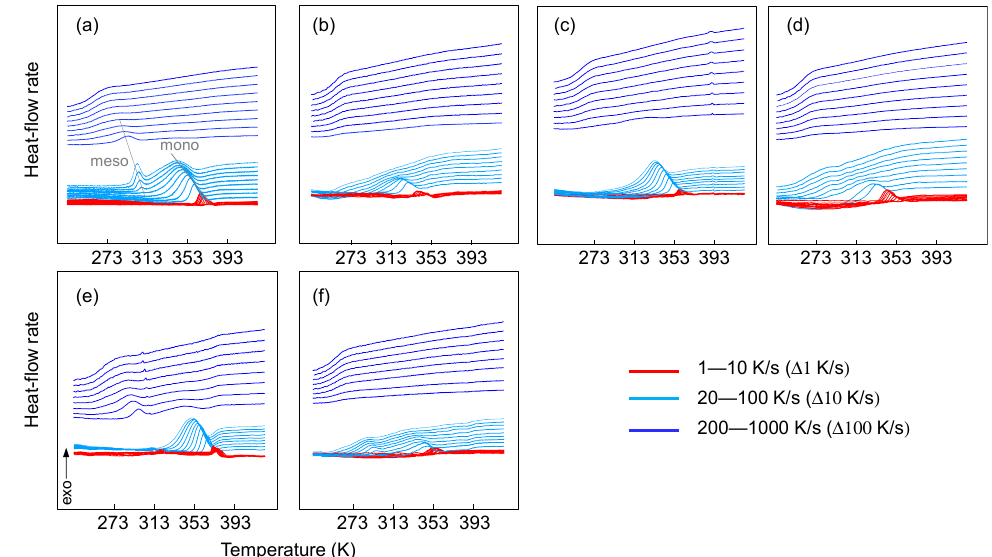
Figure 2. Heat-flow rate data collected on cooling of propylene homopolymers and random copolymers based on SSC ( top ) and ZNC ( bottom ) at different rates, as indicated. ( a ) SSC.iPP-0; ( b ) SSC.iPP.Eth-3; ( c ) SSC.iPP.Hex-3; ( d ) SSC.iPP.Hex-5; ( e ) ZN.iPP-0; ( f ) ZN.iPP.Eth-4.